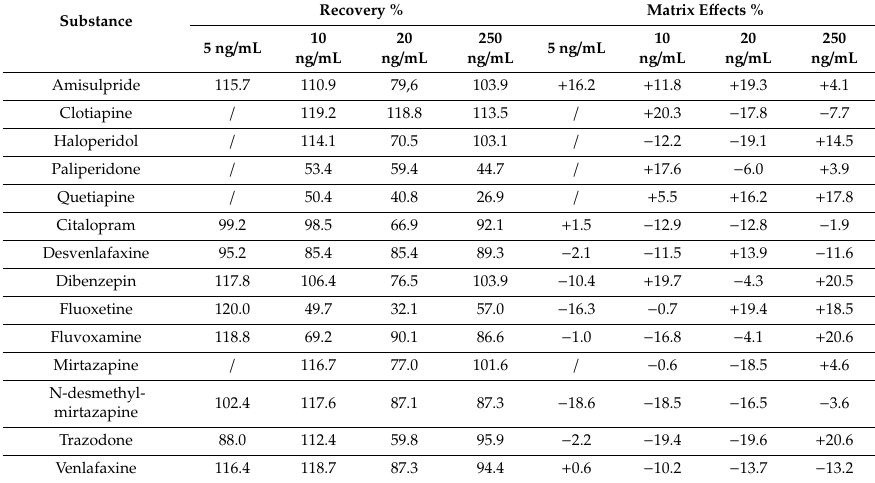
Table 3. Recovery and matrix e ff ects results (5 replicates for each